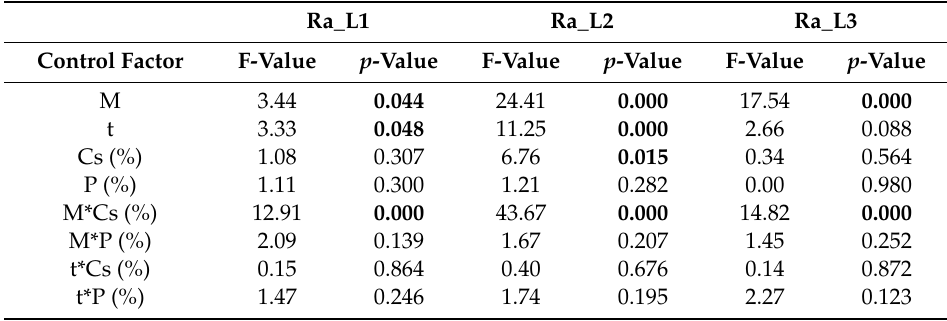
Table 7. ANOVA results for arithmetic mean surface roughness, computed F-value and p -value.